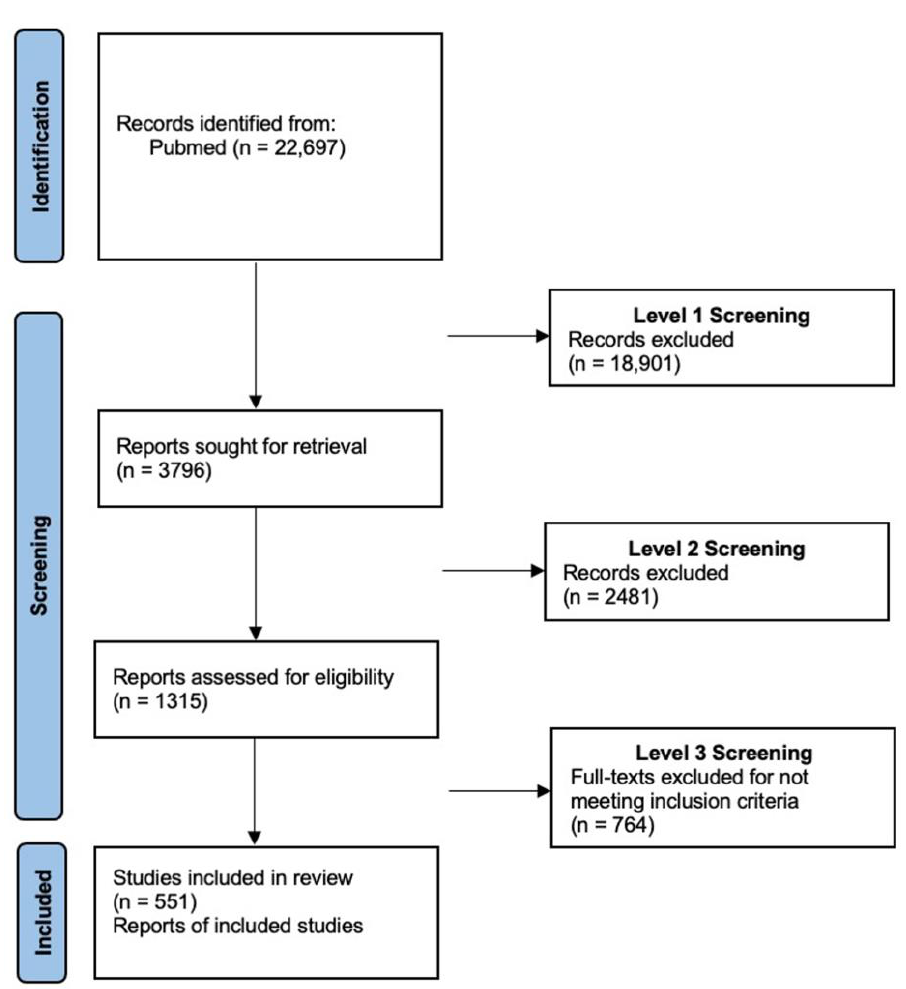
Figure 1. Preferred Reporting Items for Systematic Reviews and Meta-Analysis (PRISMA) Checklist.